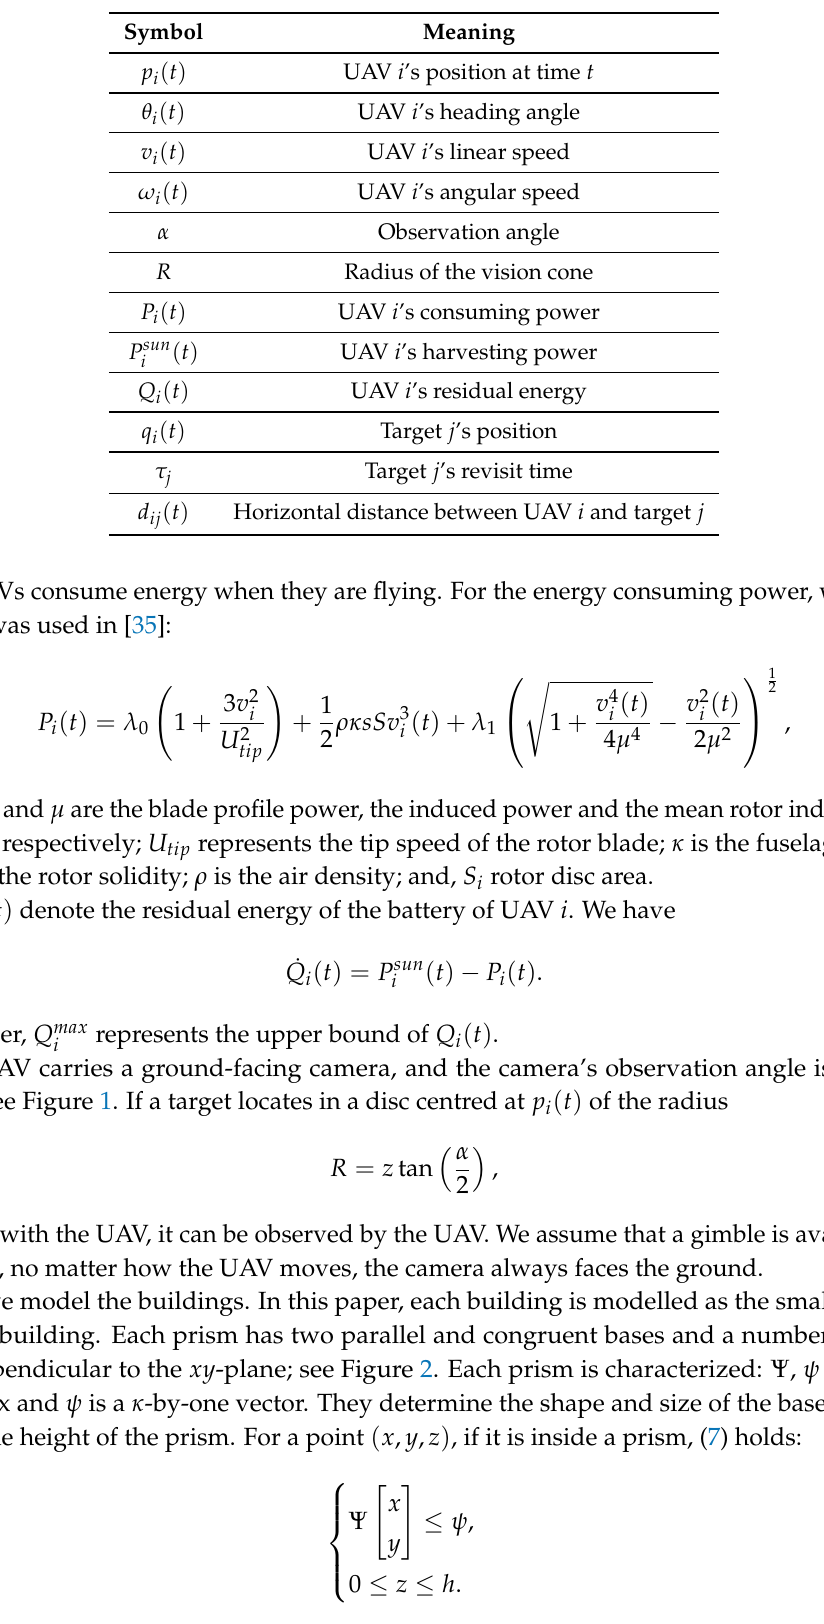
Table 1. Symbols and